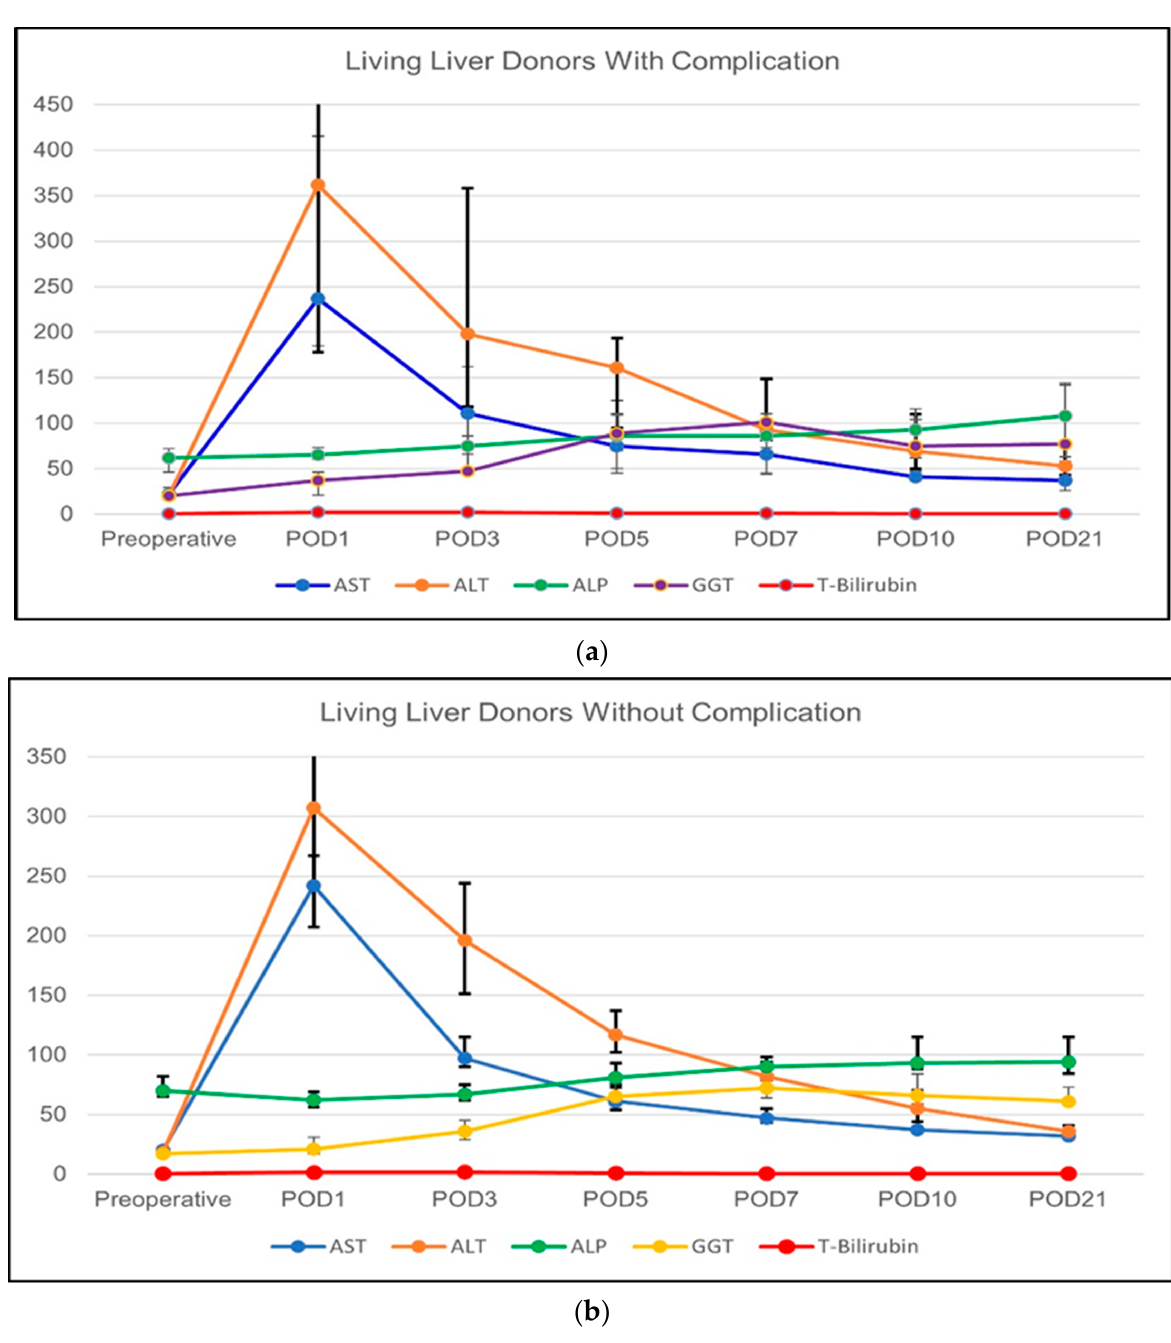
Figure 4. ( a ) The course of routine biochemical blood parameters of LLDs with postoperative complications (requiring relaparotomy); and ( b ) the course of routine biochemical blood parameters of LLDs without postoperative